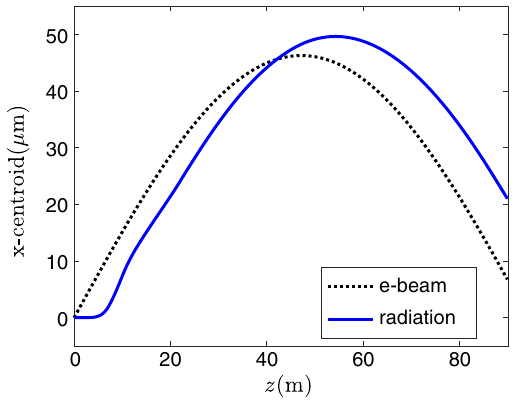
FIG. 3. Electron and radiation horizontal centroids for a kick angle of 1 . 54 μ rad (analytical